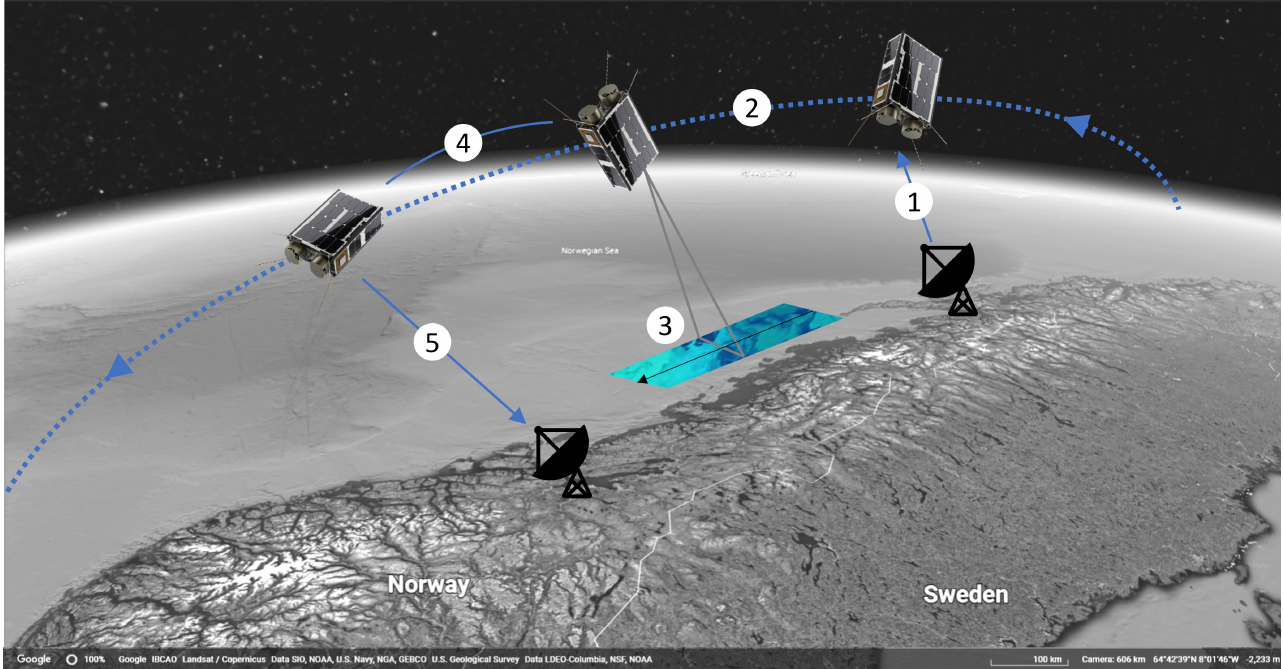
Figure 1. Simplified operational concept showing (1) uplink of commands, (2) slew maneuver, (3) pushbroom hyperspectral imaging, (4) on-board processing, and (5) downlinking of data (inspired by M. Grøtte; map from Google